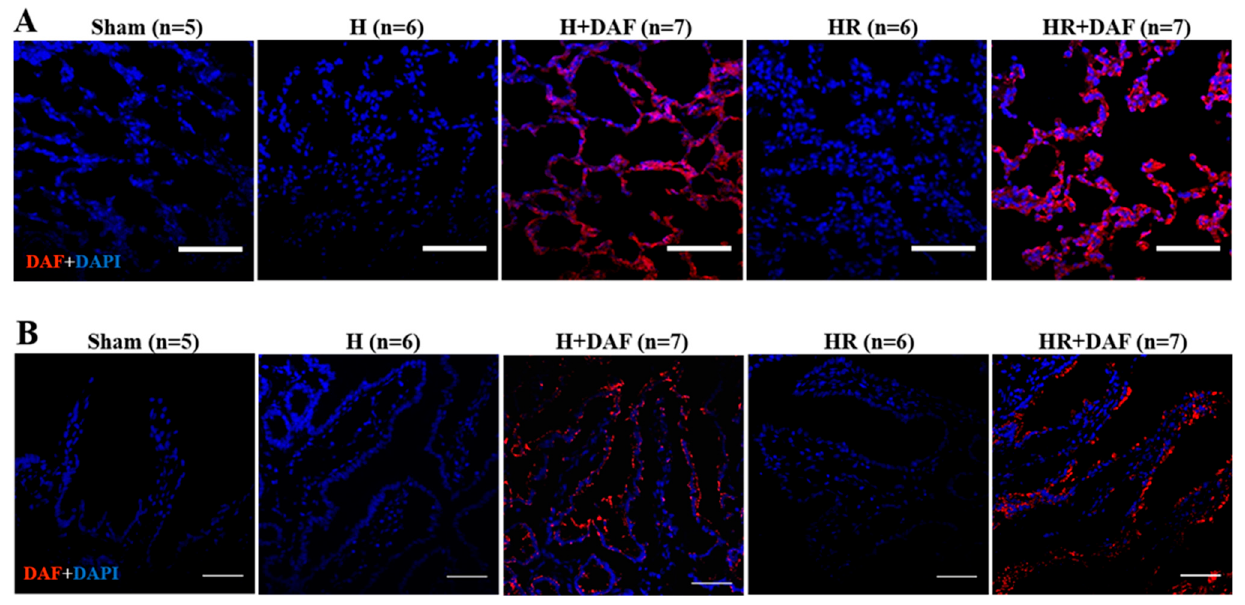
Figure 8. Intravenously administered DAF is deposited in the lung and intestinal tissues of rats. Representative lung ( A ) and intestinal ( B ) photomicrographs of immunofluorescent staining with anti ‒ human DAF. Original magnification × 400. Scale bar = 50 μ m.